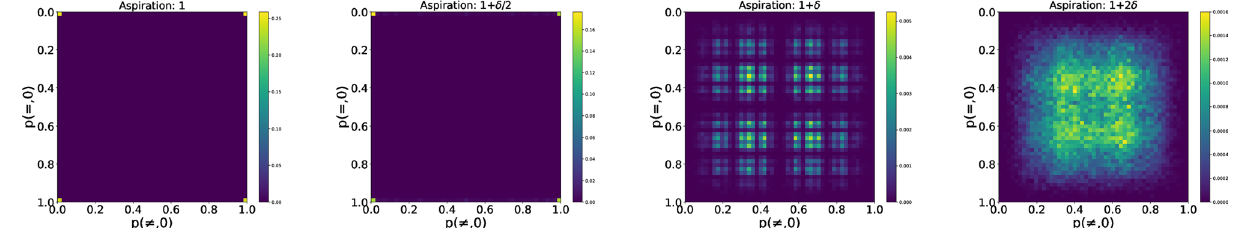
Figure 1. 2D histograms for the probability vectors of the population. Shown is the fraction of agents with specific values of choosing action 0 when facing another agent with different marker (horizontal axis) and when facing another agent with the same agent (vertical axis). From left to right, aspiration levels are 1, 1 + δ/ 2 , 1 + δ , 1 + 2 δ